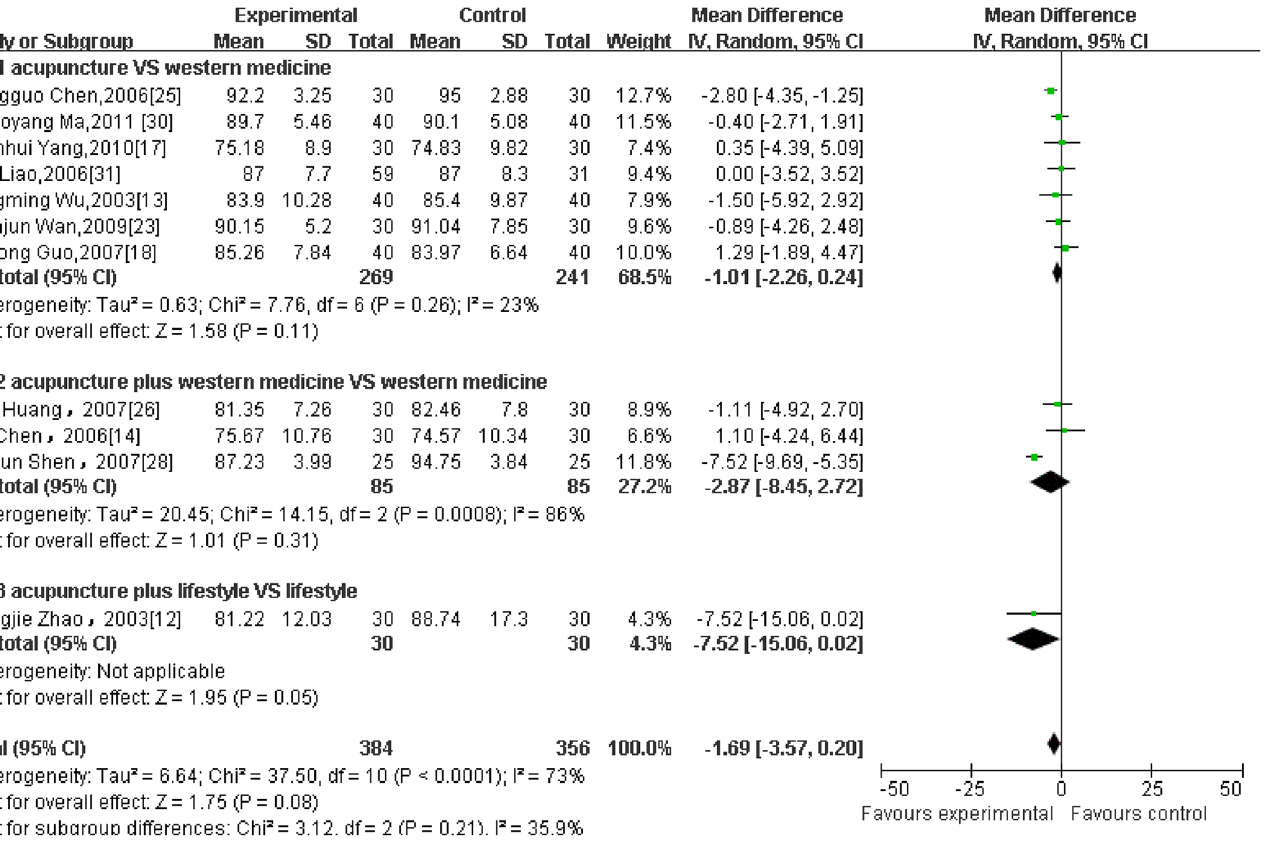
Fig 3. The forest plot of outcome measure ‘ DBP after intervention. ’